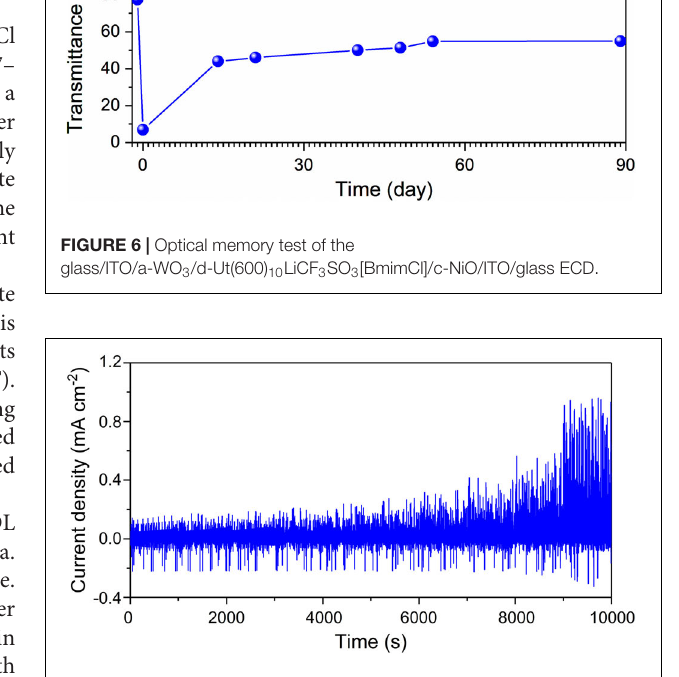
FIGURE 7 | Variation of the current density with voltage steps of –2.5/+2.5 V at every 10/50 s over ca. 167 cycles for the